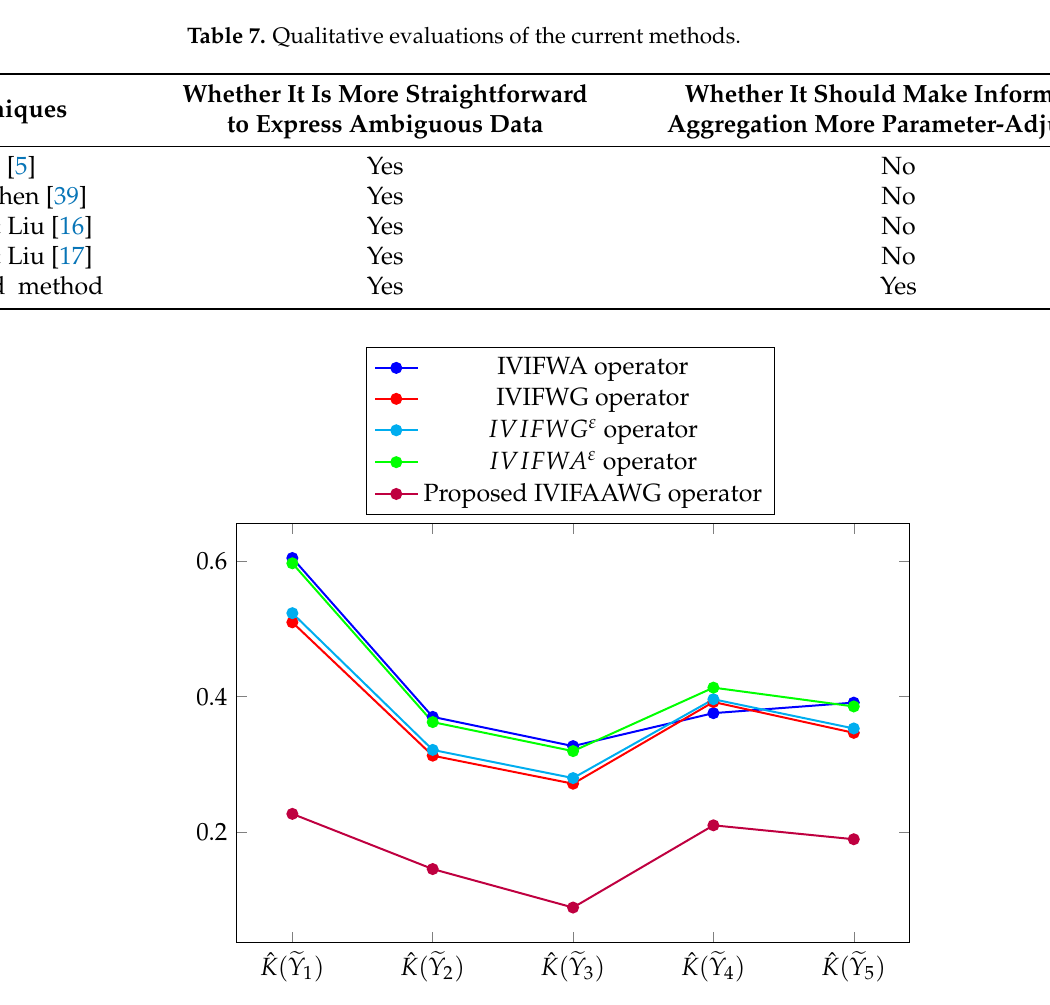
Figure 4. Comparison analysis with a few prevailing